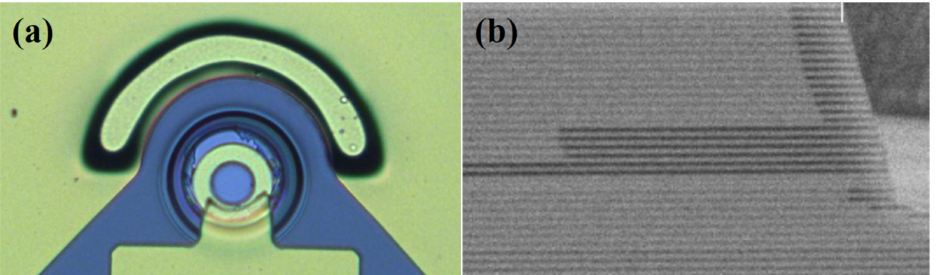
Figure 1. ( a ) Top view of the fabricated VCSEL with GSG probe pads, and ( b ) SEM image of the cross- section of the device after wet oxidation. The dark lines are the oxidized high-Al-composition